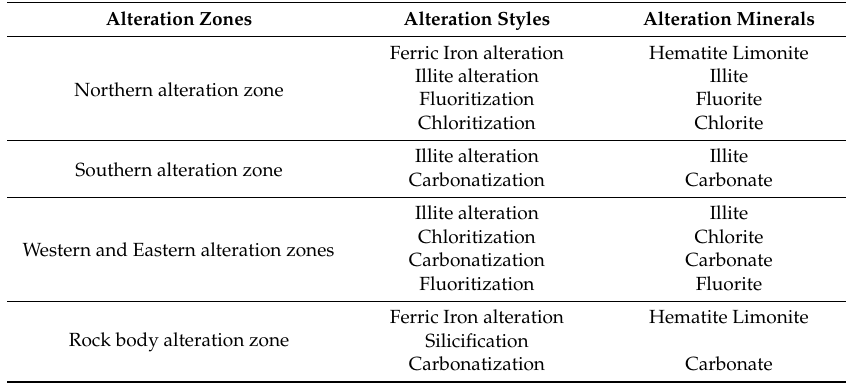
Table 1. Wall-rock alteration locations, styles and alteration minerals.